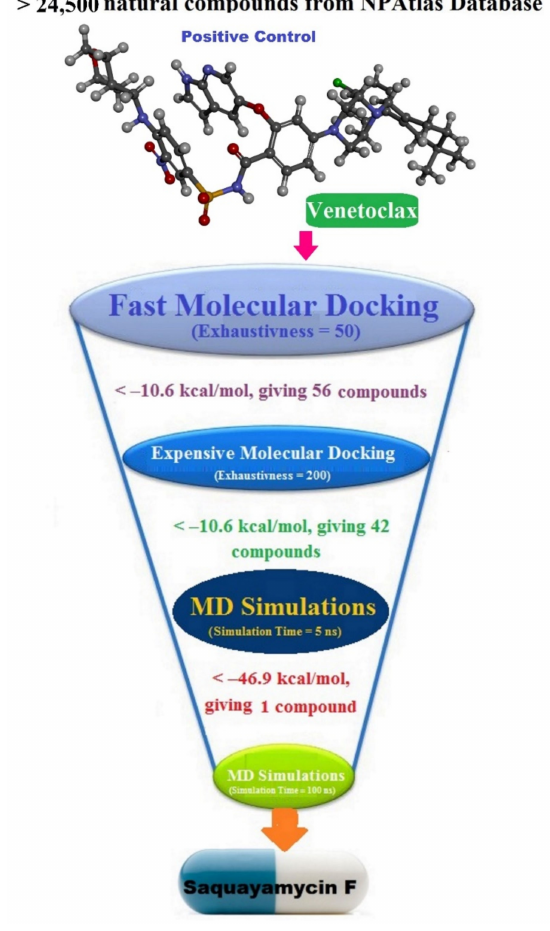
Figure 10. Schematic representation of the utilized in silico techniques in the filtration of the NPAtlas database towards identification of promising Bcl-2